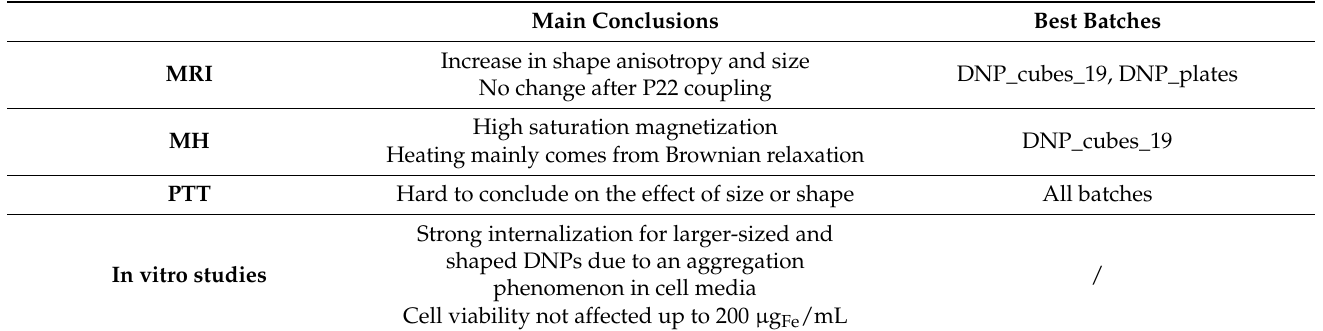
Table 8. Main conclusions on the effects of size, shape, and the presence of a TL on MRI, MH, and PTT. Main Conclusions Best Batches